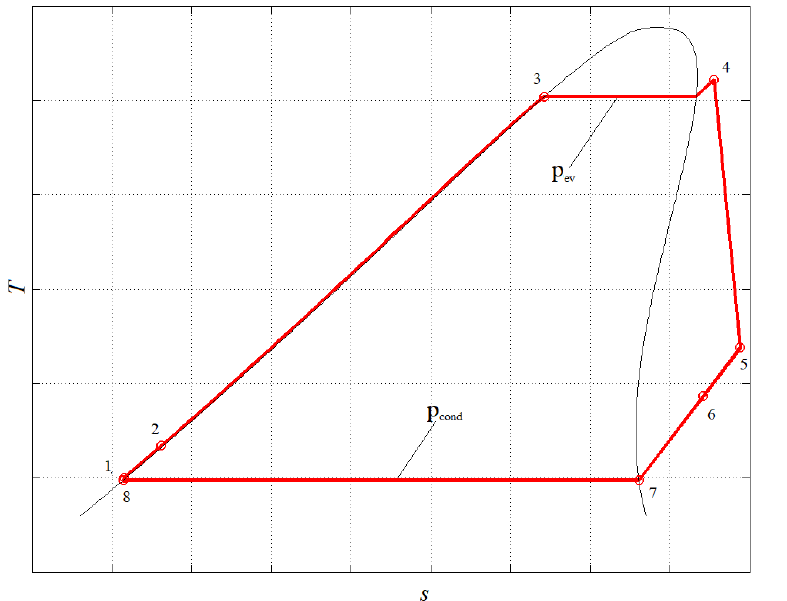
Figure A1. T-s diagram of the recuperative cycle implemented in the code. The thermodynamic state points are included in the graph to better identify their